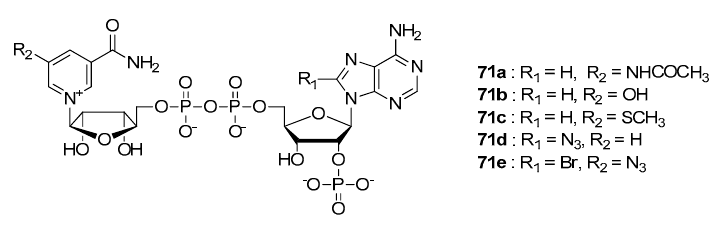
Figure 17. The most potent agonist-type NAD + analogs developed by Trabbic et al. [83].